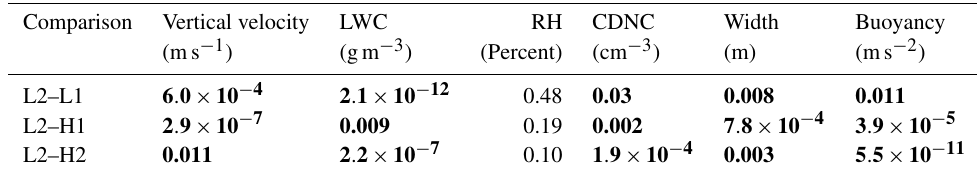
Table 10. The p values between L2 and L1, L2 and H1, and L2 and H2 for in-cloud vertical velocity (ms − 1 ), LWC (gm − 3 ), RH (%), CDNC (cm − 3 ), cloud width (m), and in-cloud buoyancy (ms − 2 ). Statistically significant values are presented in